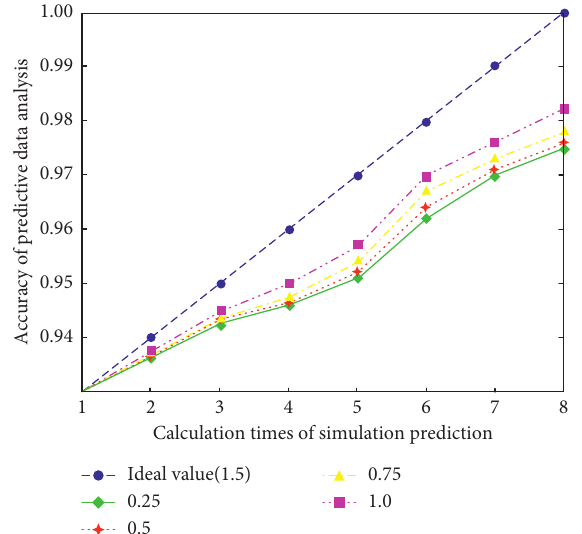
Figure 2: Simulation analysis results of the collaborative filtering algorithm under different factors for the output of the music sound database.